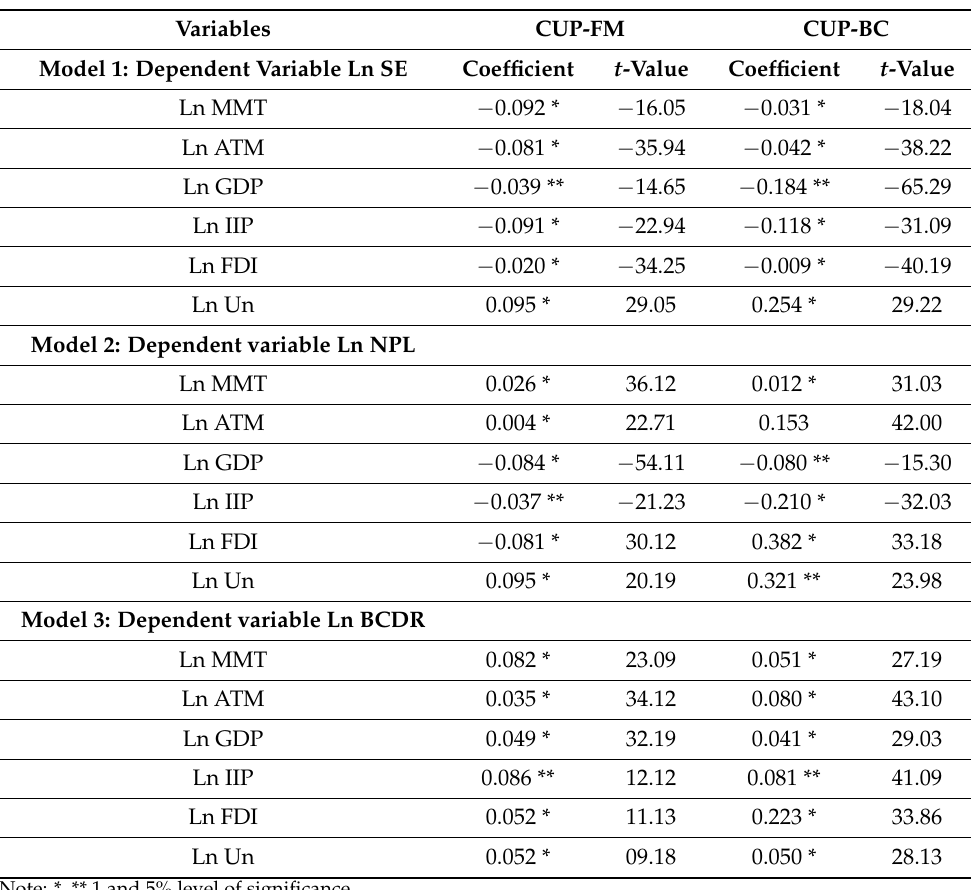
Table 6. CUP-FM and CUP-BC